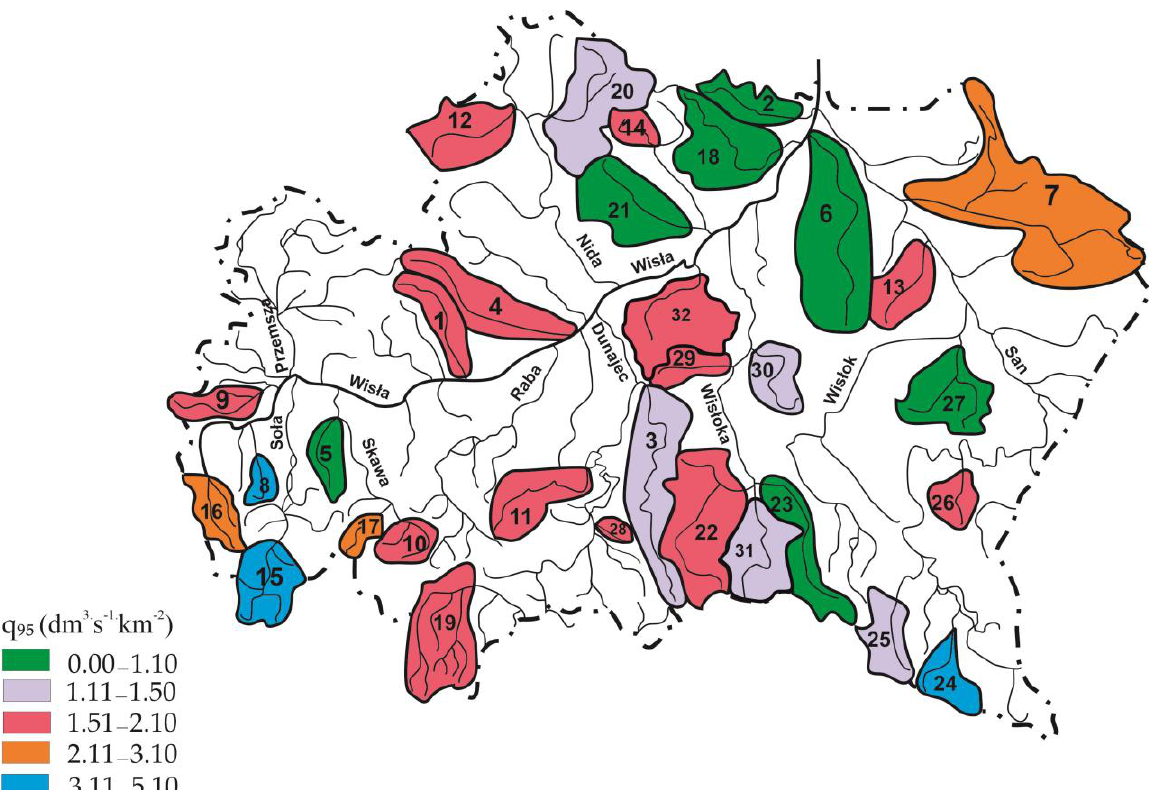
Figure 2. Specific low flow discharge q 95 for analyzed catchments of the Upper Vistula basin,